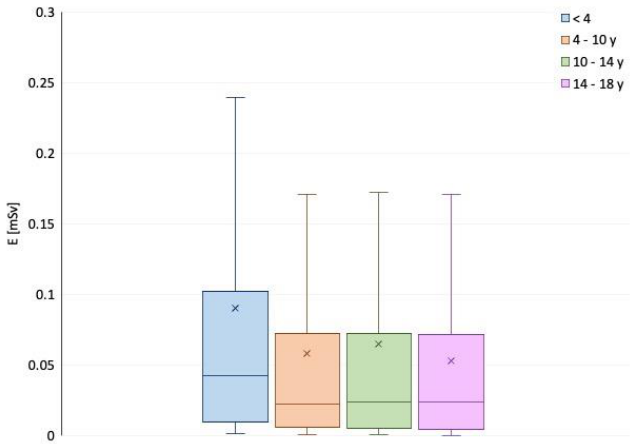
Figure 4. Radiation dose trend from 2016 to 2019 in different patient age groups.